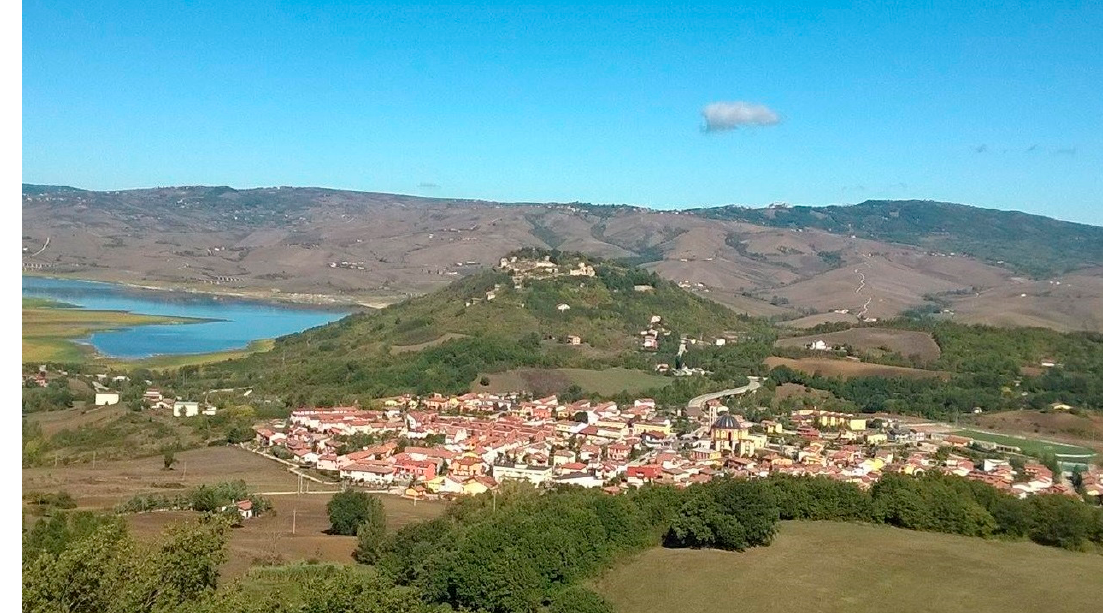
Figure 5. In the foreground, the “new Conza”. On the hilltop, the archeological park (Courtesy of Pro Loco Compsa).